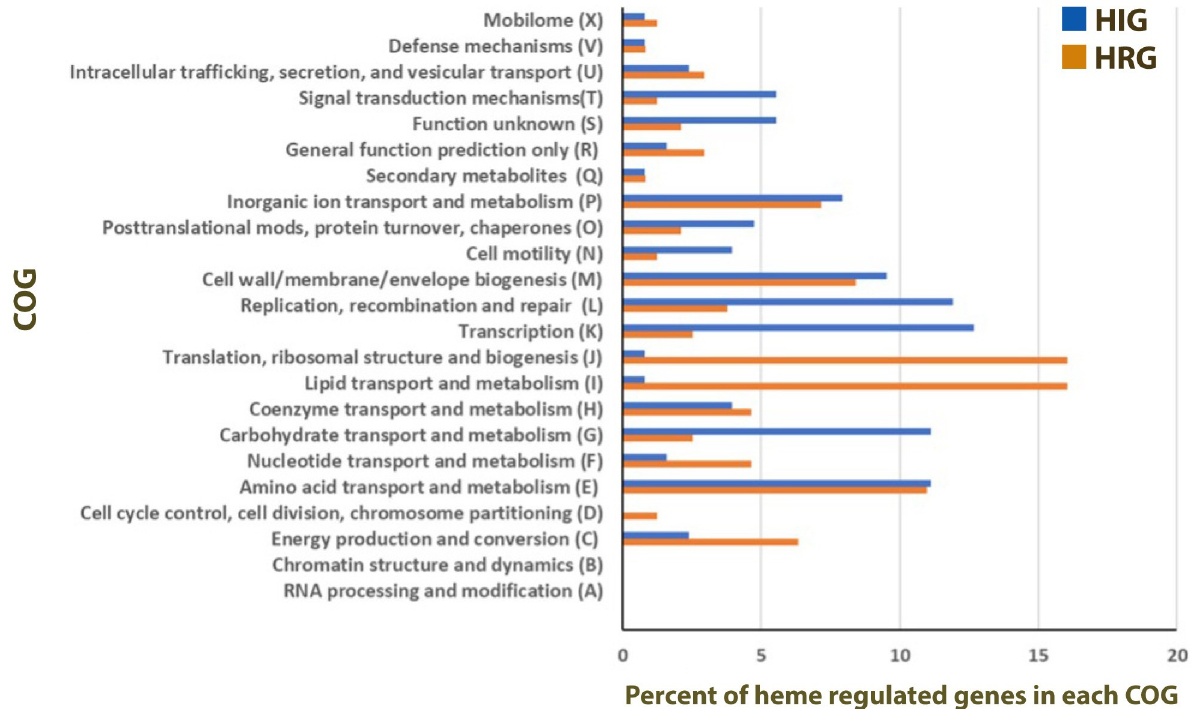
Fig 2. Distribution of heme-regulated genes in COG categories. Sgm genes that showed � 2-fold change in expression when grown in the presence of high heme (100 μ M) were grouped according to their clusters of orthologous group (COG) designations. HIG, heme-induced genes; HRG, heme- repressed